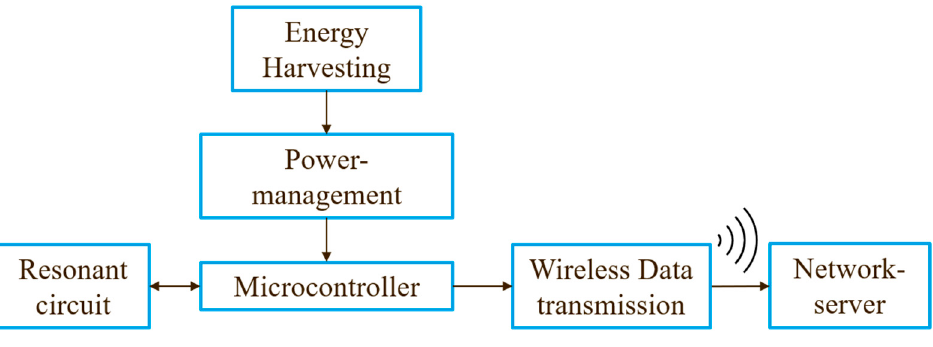
Figure 1. Sensor concept.